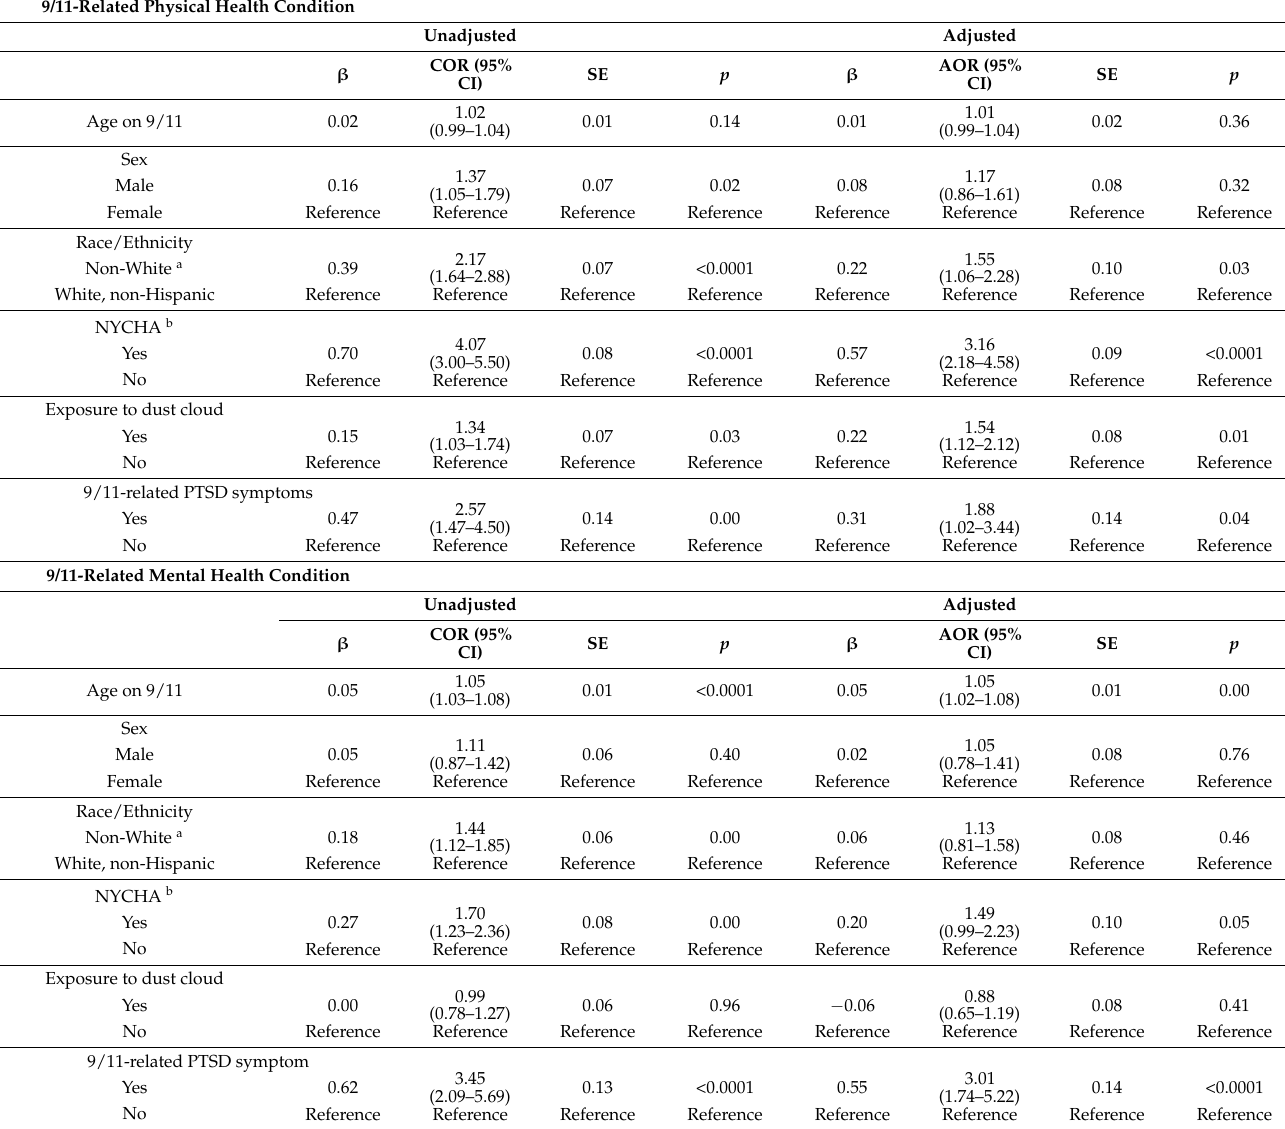
Table 3. Crude (COR) and Adjusted odds ratios (AOR) for 9/11-related physical and mental health condition hospitalizations in New York State among World Trade Center Health Registry enrollees who were ≤ 18 years of age on 9/11, 11 September 2001–31 Decmeber